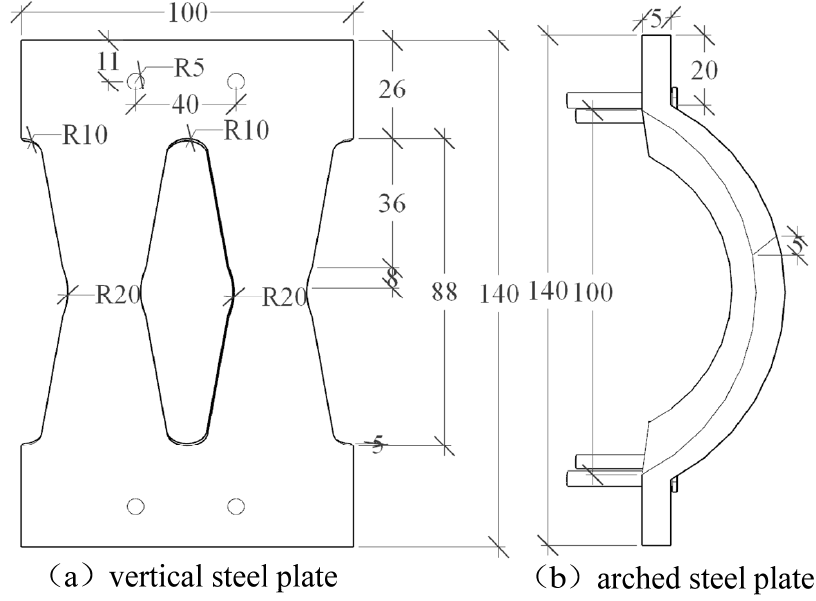
Figure 1. Model size of energy-consuming device (unit: mm). The vertical steel plate and the arched steel plate have the same projection size and bolt-hole position, which not only ensures that the two can be assembled and combined into AEDD, but also that the peeling of both can be placed on the same PSCFSTBP as an energy-dissipating element. Among them, the yield strength of the arched steel plate is greater than that of the vertical steel plate, but the weakening of the hole in the middle area of the vertical steel plate can concentrate the stress and control the